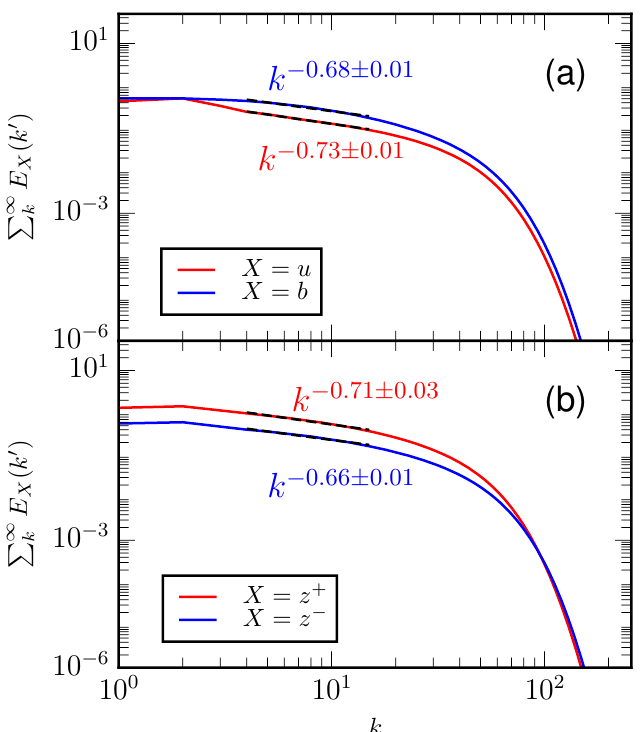
Figure 3. Time-averaged cumulative spectra of ( a ) the kinetic energy (solid red curve) and magnetic energy (solid blue curve), and ( b ) z + (solid red curve) and z − (solid blue curve). These spectra are close to k − 2/3 indicating consistency with the Kolmogorov-like spectra for MHD